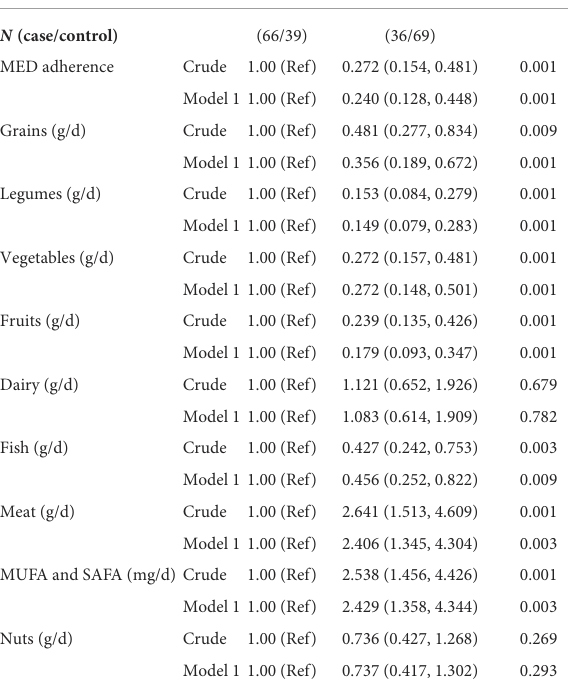
TABLE 4 Association between MED adherence, its components, and odds of DN ( n =